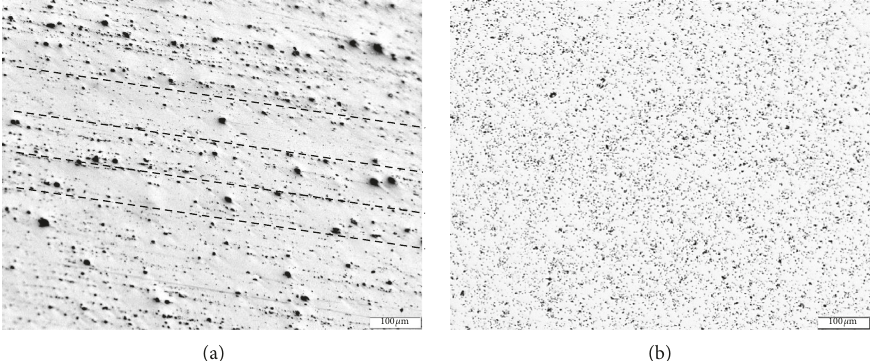
Figure 9: Comparison between morphology and population of precipitates found in (a) BM and (b)